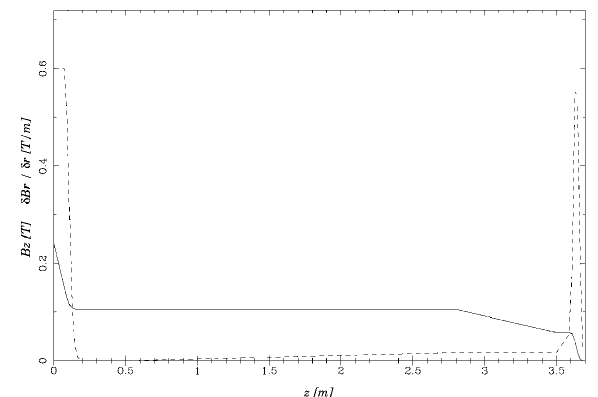
FIG. 4. Solenoid field strength B z (solid line) and radial deriva- tive dB r (cid:3) dr (dashed line) as a function of position along the beam line.